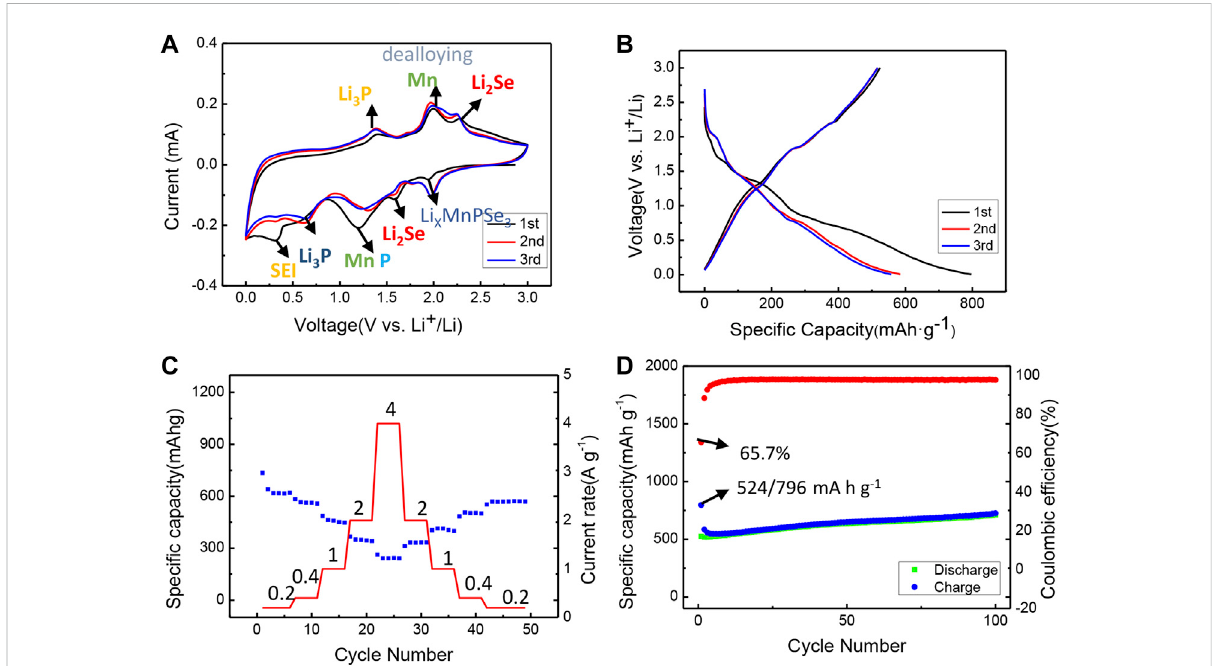
FIGURE 6 Electrochemical performance of exfoliated MnPSe 3 as anode in Li ions half-cell. (A) The CVs of the initial three cycles in the voltage window of 0.005 – 3 V at 0.05 mV s − 1 . (B) Galvanostatic discharge/charge pro fi les for the fi rst three cycles in the voltage window of 0.005 – 3 V (vs. Li + /Li) at 0.2 A g − 1 . (C) Rate performance of MnPSe 3 anode within the potential of 0.005 – 3 V vs. Li + /Li at different current densities from 0.2 A g − 1 to 4 A g − 1 . (D) Cycling performance of exfoliated MnPSe 3 electrode tested within the potential of 0.005 – 3 V (vs. Li + /Li) at 0.2 A g − 1